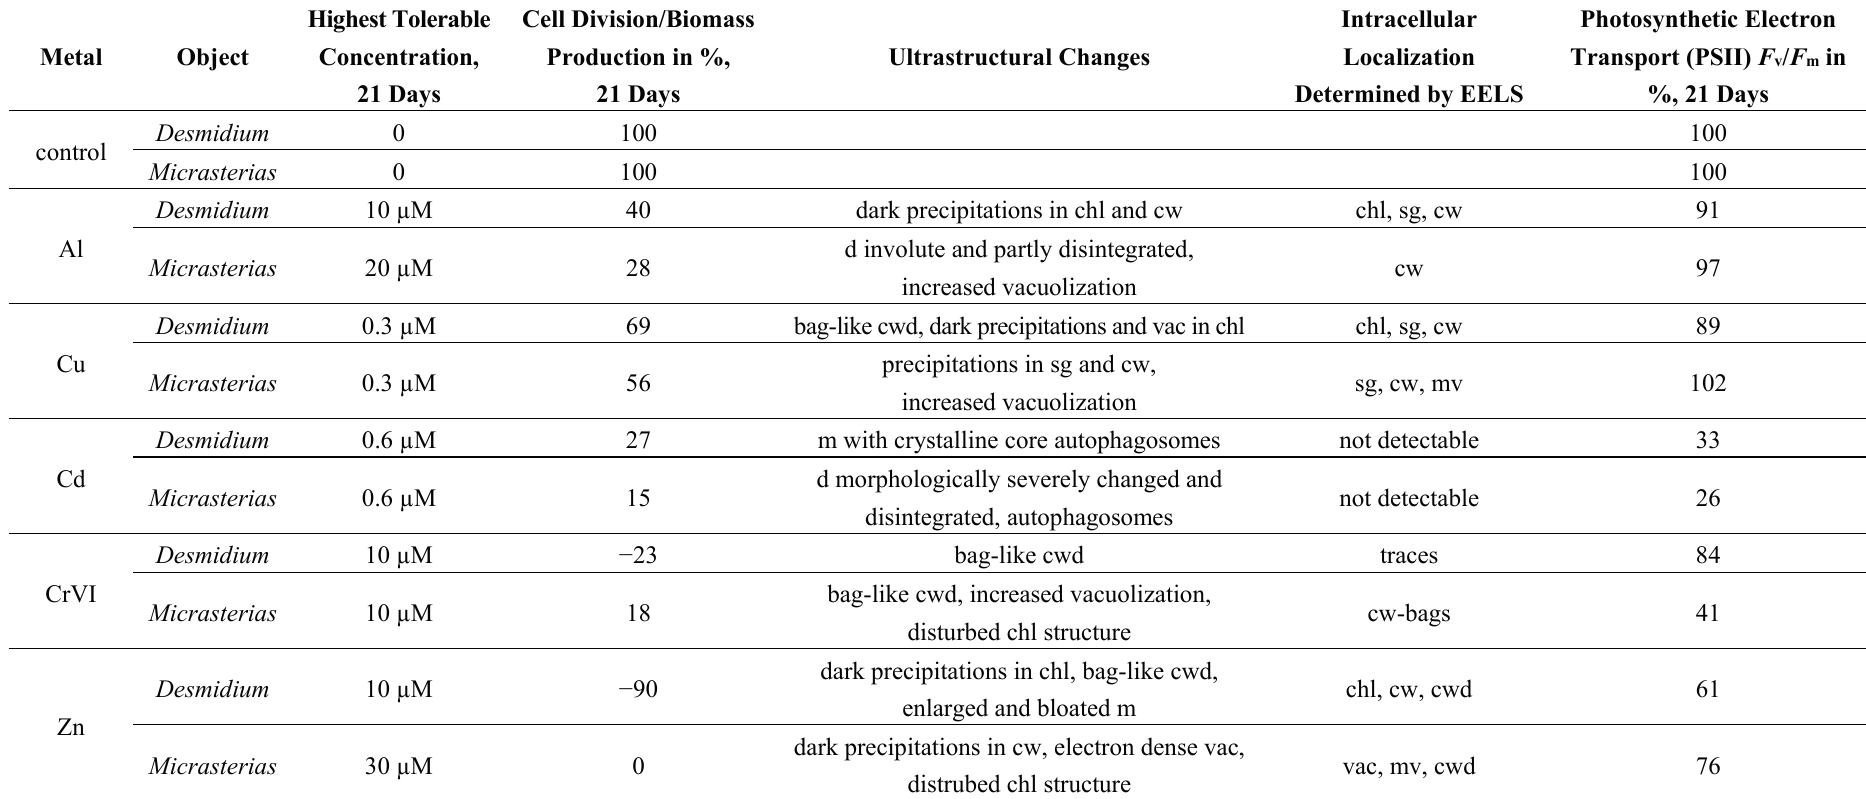
Table 1. Comparison of metal effects between the multicellular filamentous alga Desmidium and the unicellular alga Micrasterias . Data for Desmidium taken from this study, for Micrasterias from Volland et al. [4,13] and from Andosch et al. [3]. For details see Section 4.8., statistics are given in original publications. Chl: Chloroplast, cw: Cell wall, cwd: Cell wall depositions, d: Dictyosomes, sg: Starch